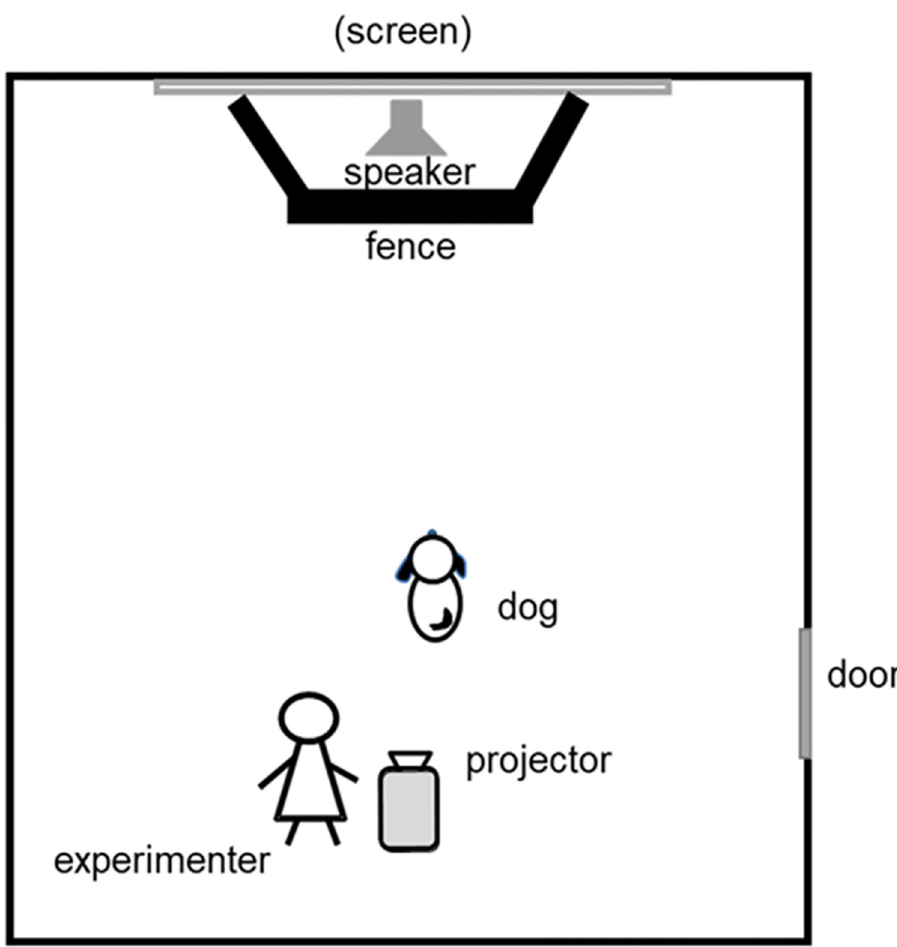
Fig 1. An experiment